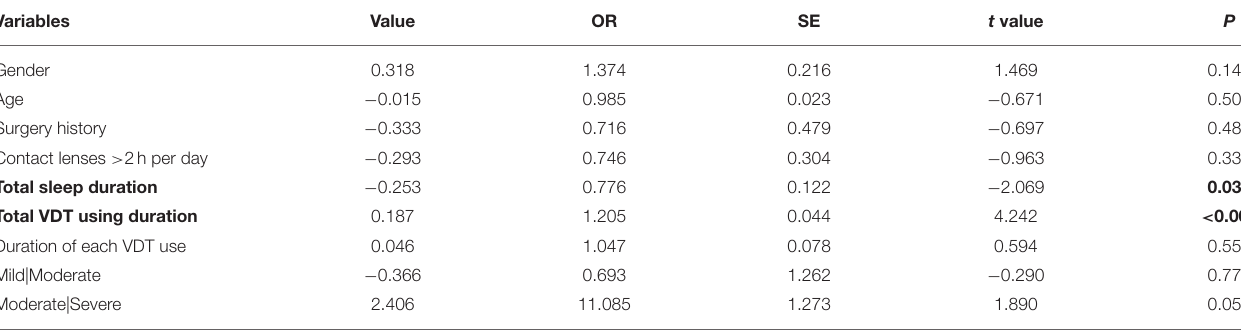
TABLE 4 | Ordinal logistic regression for related factors for the severity of eye discomfort symptoms. Variables Value OR SE t value